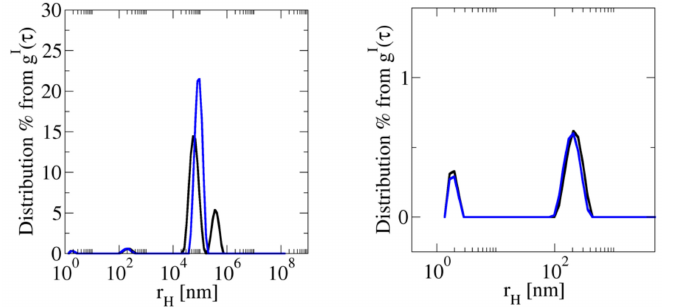
Figure 11. Left : The derived size distribution obtained from the measurements presented in Figure 12. Right : close-up of the smaller particles in the solution; besides the monomers with R H ~2 nm, larger structures of R H ~110 nm are present in the solution. The black line corresponds to the distributions obtained from the first DLS measurement, whereas the blue line indicates the results of the last